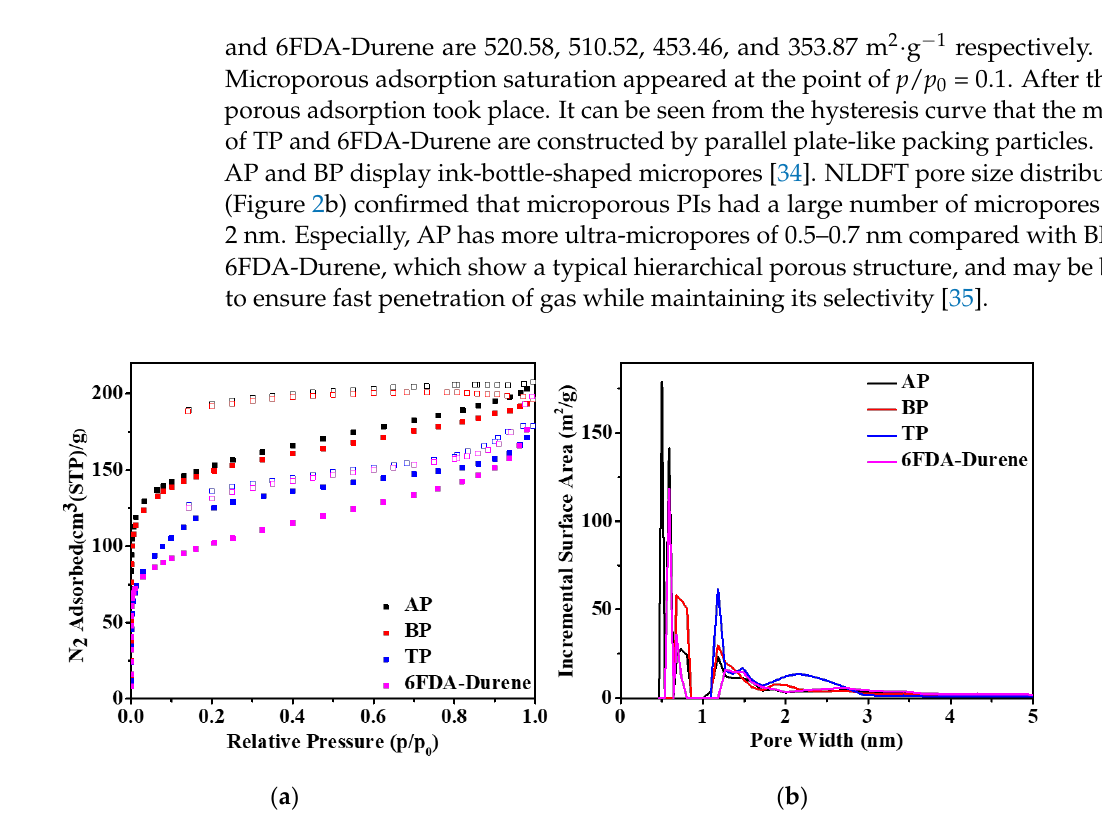
Table 2. Physical properties of continuous phase and dispersed phase.